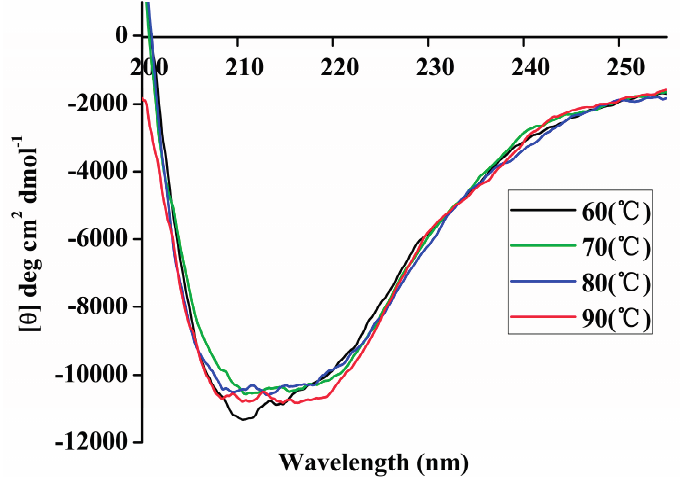
Figure 7. Far-UV CD spectra of rP186_1588 recorded in the 250 nm–200 nm range at different temperatures (60 °C, black; 70 °C, green; 80 °C, blue; 90 °C, red).